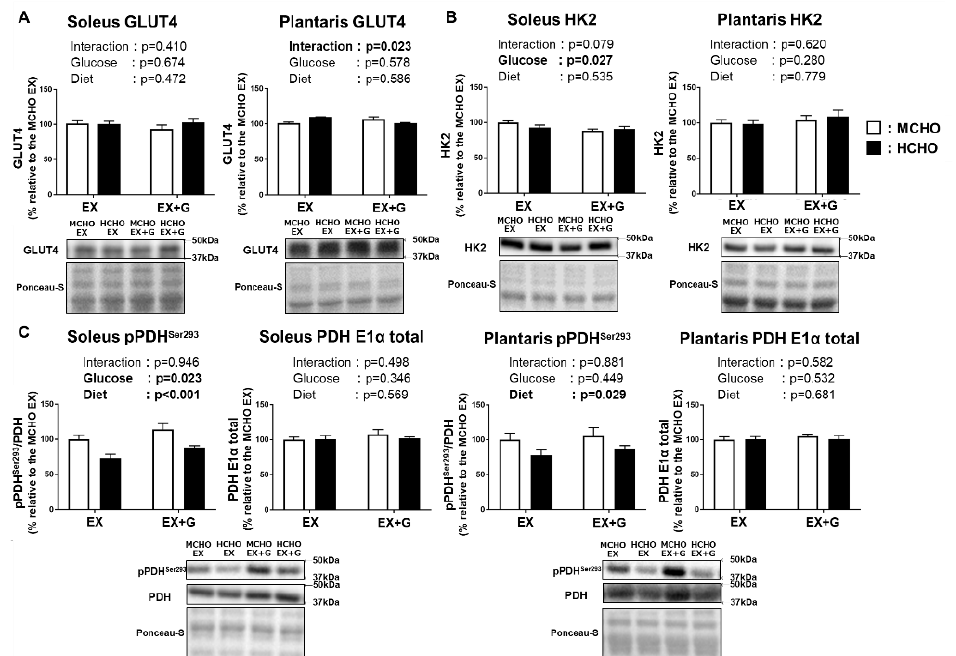
Figure 5. Protein levels of GLUT4 ( A ), hexokinase 2 (HK2) ( B ), and phosphorylated pyruvate dehydrogenase (PDH) E1α subunit Ser 293 ( C ) in mice fed the HCHO (black) or MCHO (white) diet for 10 days (n = 6–8). Tissues were harvested as described in the Figure 2 legend. Values are mean ± SE. All data are shown as relative values against the MCHO EX group.